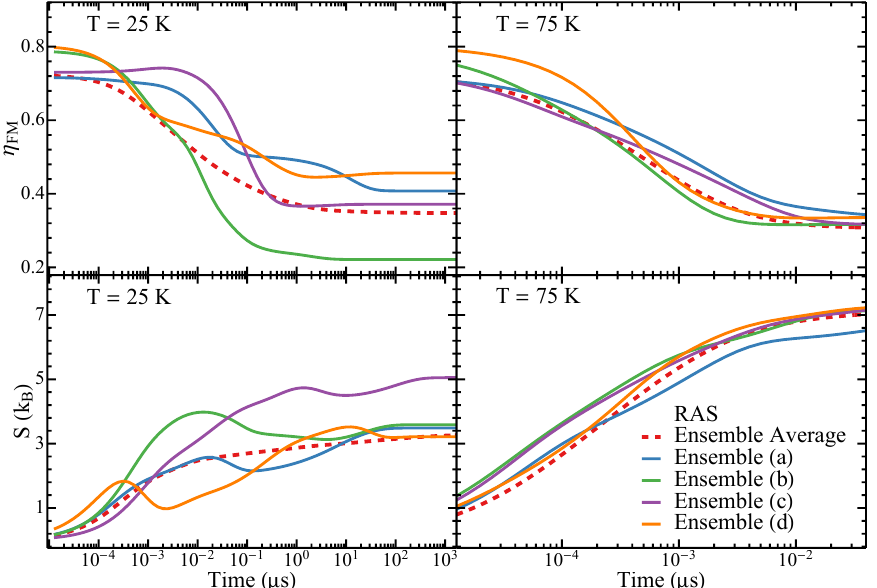
Figure 8. The time dependence of the ferromagnetic (FM) order parameter and of the configurational entropy S of the SD ensembles illustrated in Figure 5 (solid curves) following an isothermal relaxation after saturation (RAS) are shown. Moreover, the average of η FM and S over 100 different realizations of the nanostructures are given by the dashed curves. The simulation temperatures are